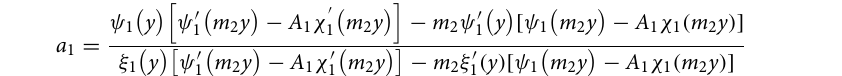
Fig. 4, analytical results for the real and imaginary parts of the effective permittivity (solid lines) are compared with numerically extracted results (dash lines).